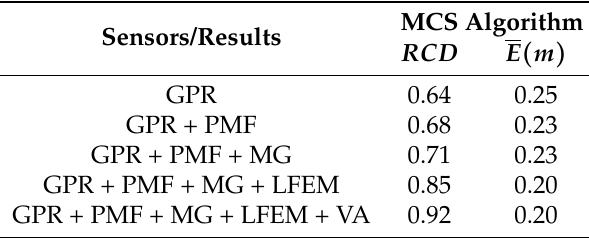
Table 3. Experimental results of MCS with virtual scan lines on the data of the Glen Eyre site survey: RCD is the rate of correctly located utility length compared with the ground truth, RCD ∈ [ 0,1 ] ; E (m) is the average distance error of the located utility